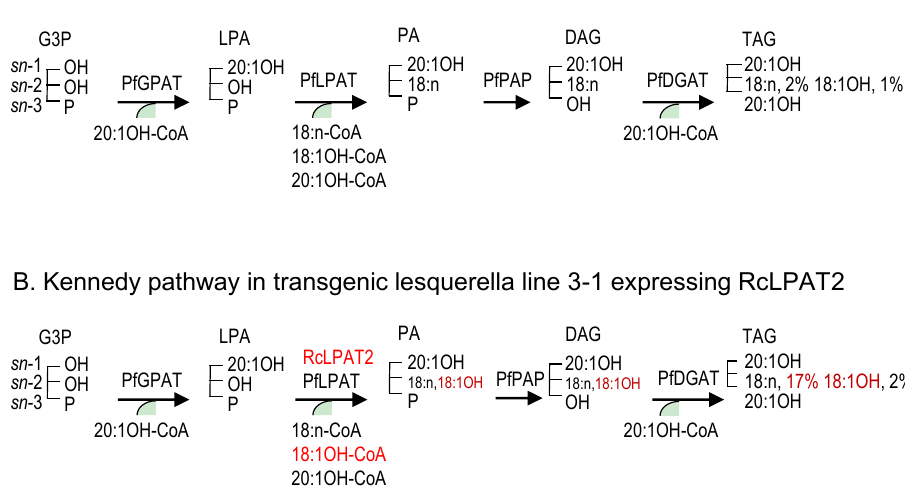
Figure 4. Simplified figure showing the effect of RcLPAT2 on the TAG biosynthetic pathway in lesquerella focusing on the Kennedy pathway. In the Kennedy pathway sequential acylation of a glycerol backbone takes place, by the GPAT, LPAT and DGAT enzymes in order to generate TAG. ( A ) In lesquerella the GPAT and DGAT enzymes have high selectivity for 20:1-OH leading to acylation of the sn -1 and sn -3 positions of the glycerol backbone with 20:1-OH. LPAT has specificity for non-hydroxylated FAs, preventing the incorporation of significant amounts of HFA (~2%18:1-OH and ~1% 20:1-OH) at the sn -2 position of the glycerol backbone (Figure 3); ( B ) In transgenic lesquerella seeds expressing RcLPAT2, e.g., line 3-1, approximately 19% of FAs at the sn -2 position of TAG consist of HFAs (~17% 18:1-OH and ~2% 20:1-OH) (Figure 3). However, the total amount of HFAs in the seed oil is not increased, which leads to a decrease in acylation of 20:1-OH the sn -1 and sn -3 positions (Tables 1 and 2). This indicates that RcLPAT2 has a high specificity for acylating 18:1-OH to the sn -2 position of LPA in lesquerella, which results in an increased amount of tri-HFA-TAGs in transgenic seed oil (Figure 2). 18:n means 18:1, 18:2, or 18:3, described as in Table 2. Other abbreviations are as in Figure 1. Red words show the effect of RcLPAT2.